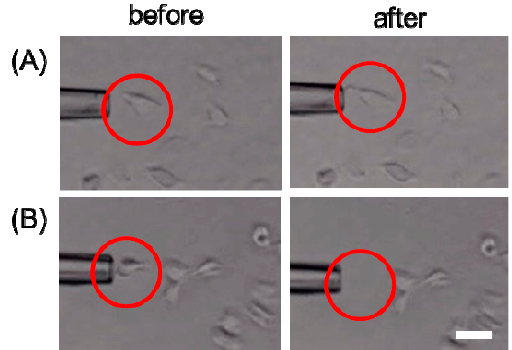
Figure 9. 3D laser microscopic images at different temperatures of AuNP-embedded collagen gels made from Cellmatrix type I-A and Cellmatrix type I-C. Bar: 20 µ m.